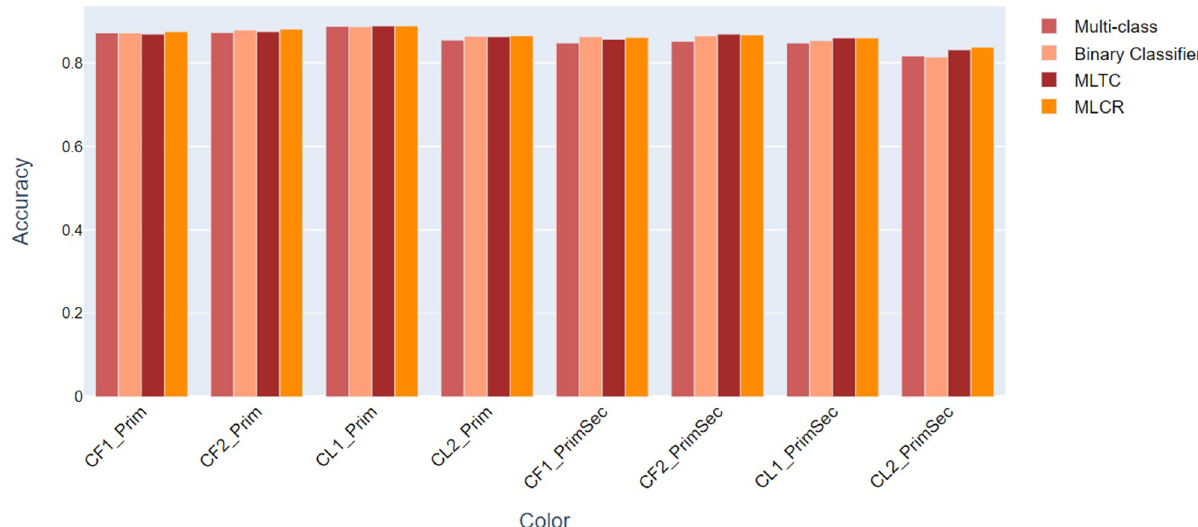
Fig 9. Overview of the performance of the various classifiers